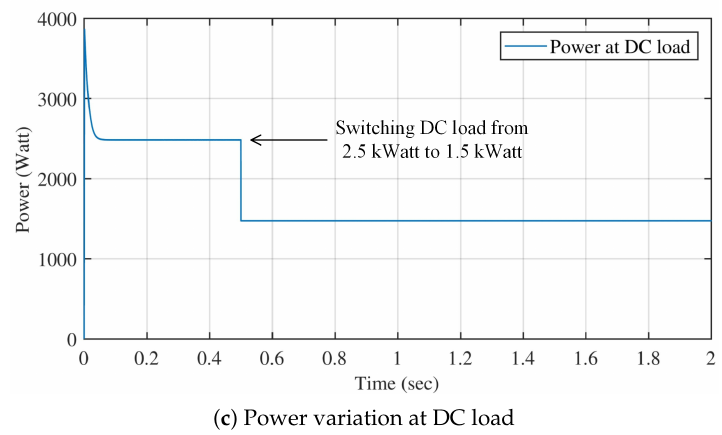
Figure 10. Case 3: Step load increment